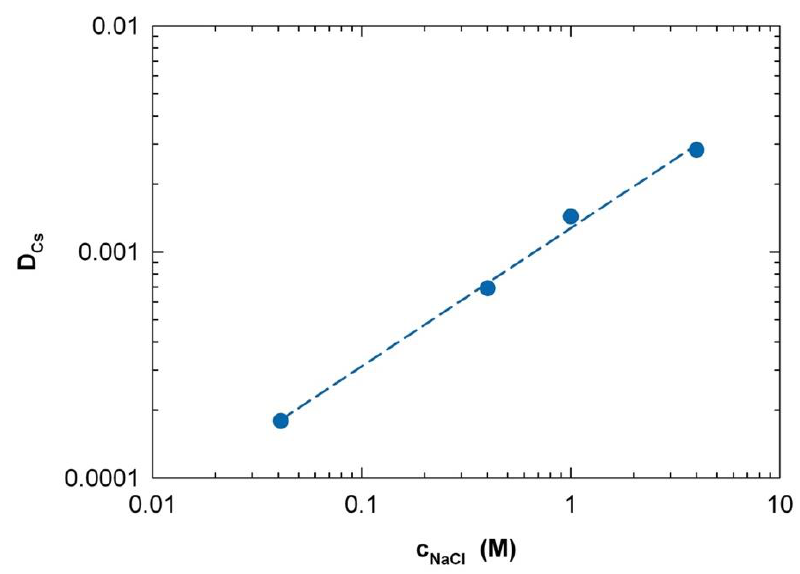
Figure 2. Cs + extraction by 1-octanol as a function of NaCl concentration. Organic phase, 1-octanol. Aqueous phase, NaCl + 0.001 M HCl + 137 Cs (10 kBq/mL).